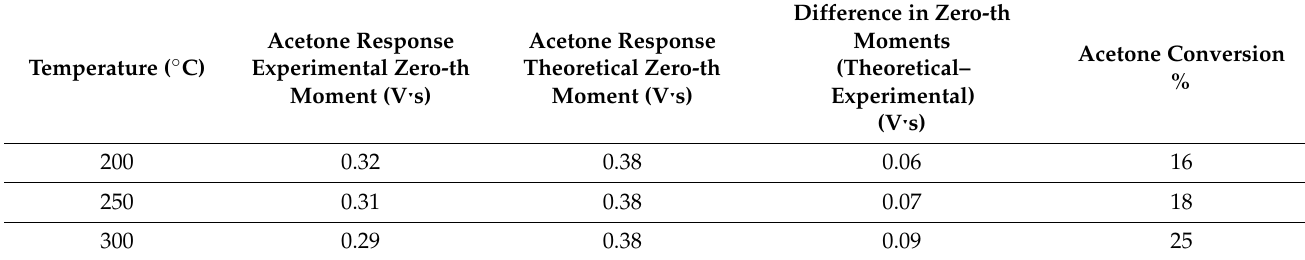
Table 5. Evidence of acetone oxidation reaction over the 5 mg catalyst at 200, 250, and 300 ◦ C.